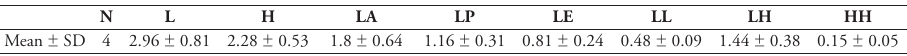
table 2. Measurements of internal shell features.